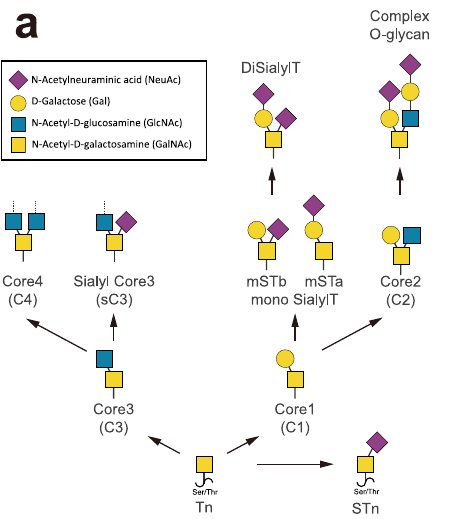
Fig. 1 | Summary of mucinases/ O -glycoproteases cleavage motif. a The O -gly- cosylationbiosyntheticpathway.TheGalNAc,Gal,GlcNAc,andSiaarerepresented as a yellow square, a yellow circle, a blue square, and a magenta diamond, respectively, and according to the symbol nomenclature for glycans (SNFG) describedforthesemonosaccharides 60 . b Cleavagemotifsforthemucinasesand O - glycoproteases described in the previous literature. The accepted subsite